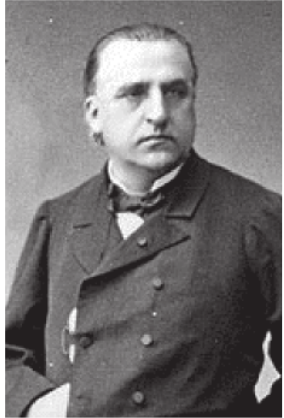
Figure 1 - J-M Charcot (1825-1893) (Extracted from http://